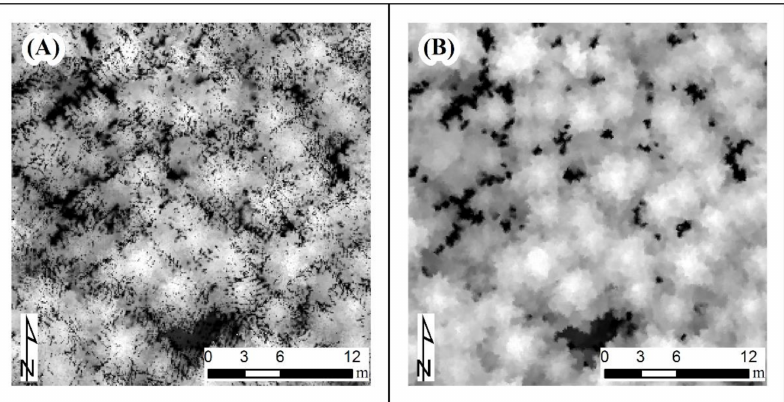
Figure 2. The comparison of canopy height models generated by ( A ) traditional first-echoes interpo- lation and ( B ) a graph-based progressive morphological filtering